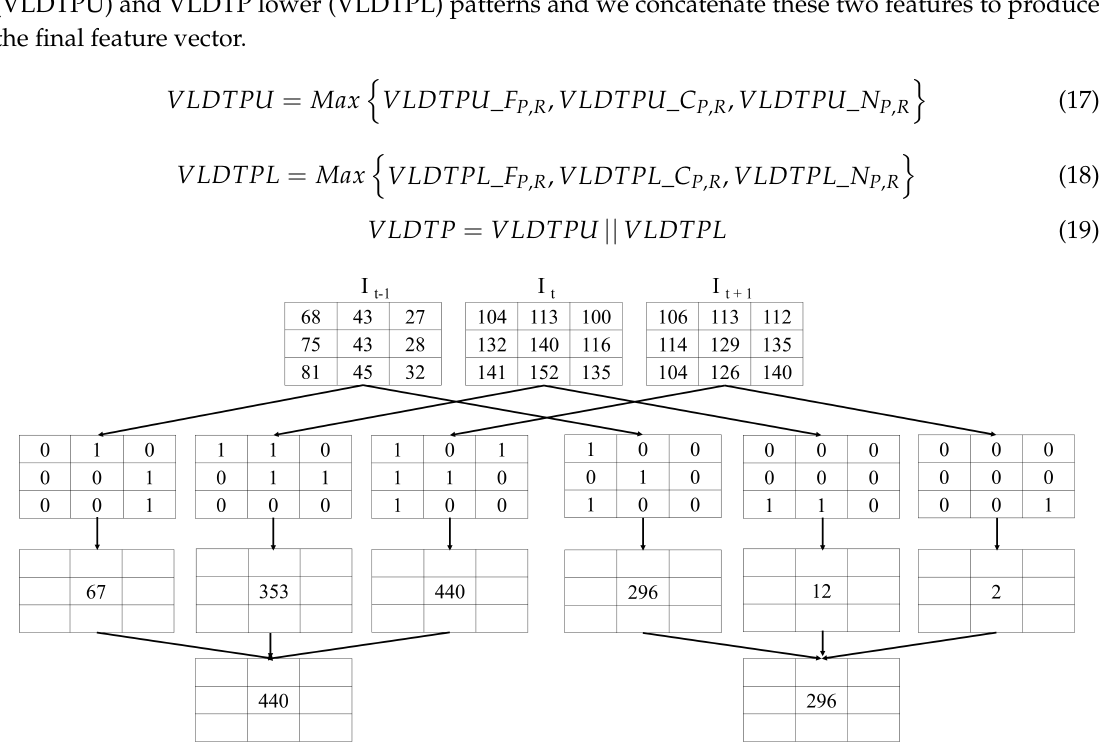
Figure 8. Illustration of the volume local directional ternary pattern